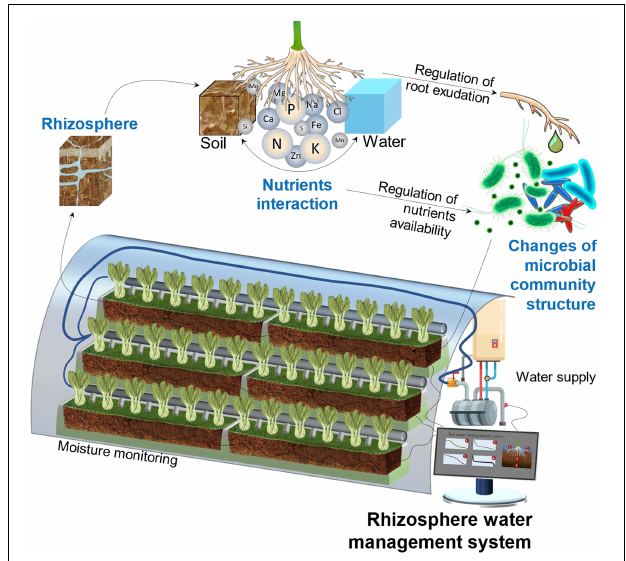
FIGURE 2 | Important influential units of a CEA system under rhizosphere water management (drawn by the authors).